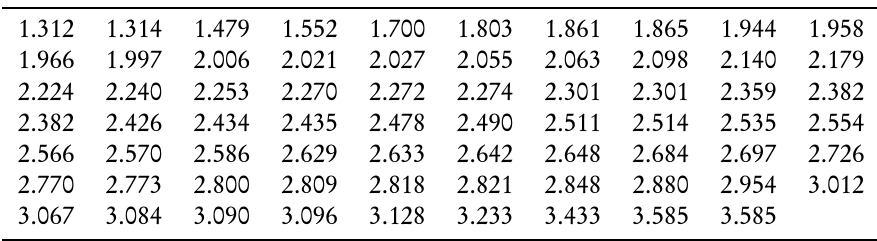
Data set 2 (Y: gauge length 20 mm).